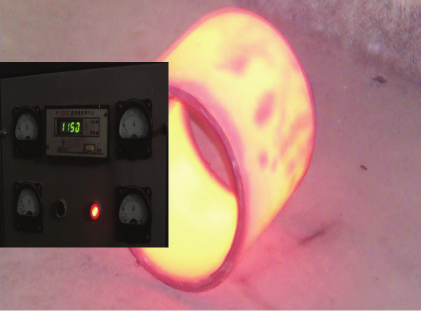
Figure 9: Bimetallic bush after